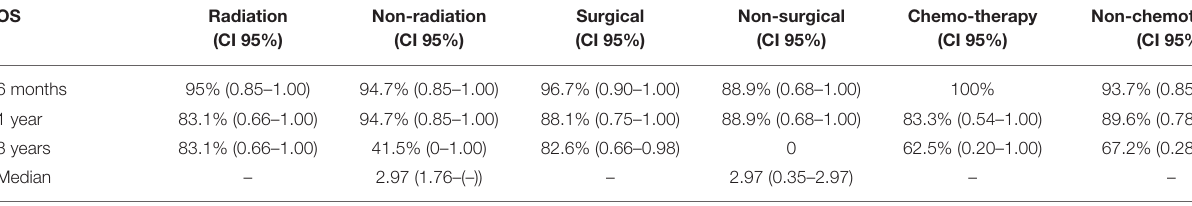
TABLE 4.3 | Median overall survival and overall survival based on treatment history at 6 months, 1 year, and 3 years ( n = 43).